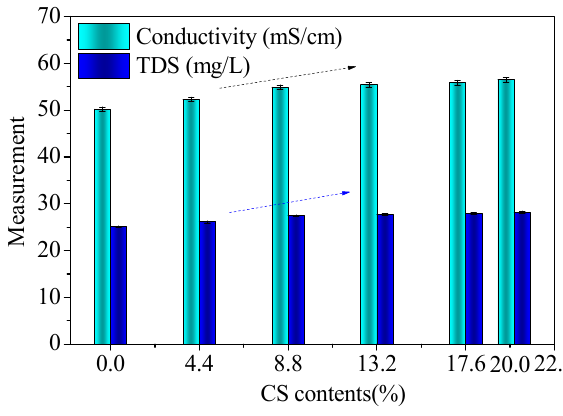
Figure 4. The conductivity and TDS of fresh CS − FA − GEO mixtures with different CS contents.